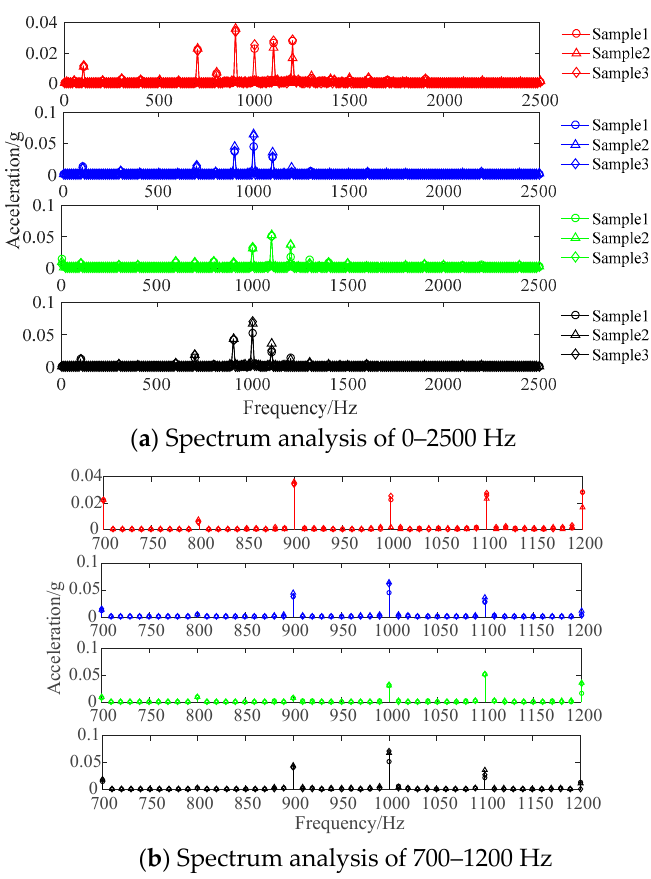
Figure 3. Spectrum analysis of vibration signals in different working conditions.